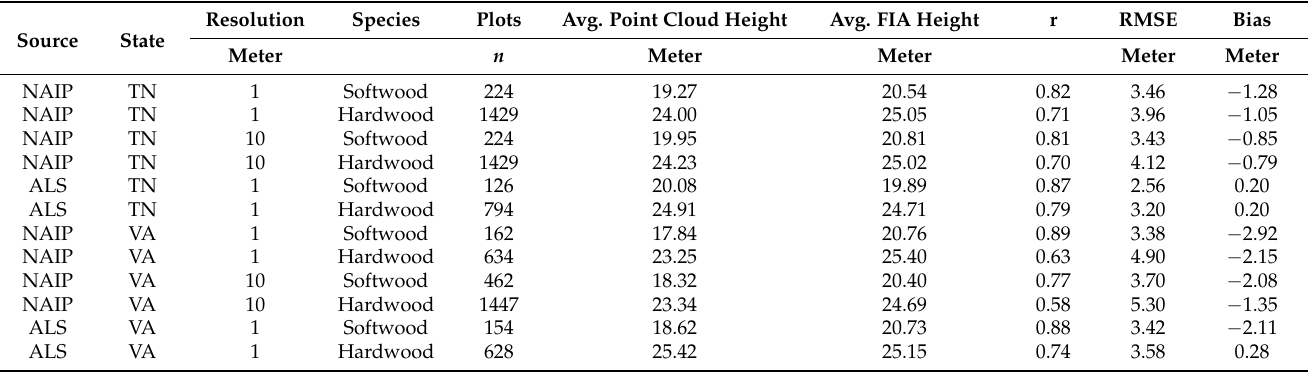
Table 3. Summary of maximum height comparison between the NAIP point cloud data and FIA field measured